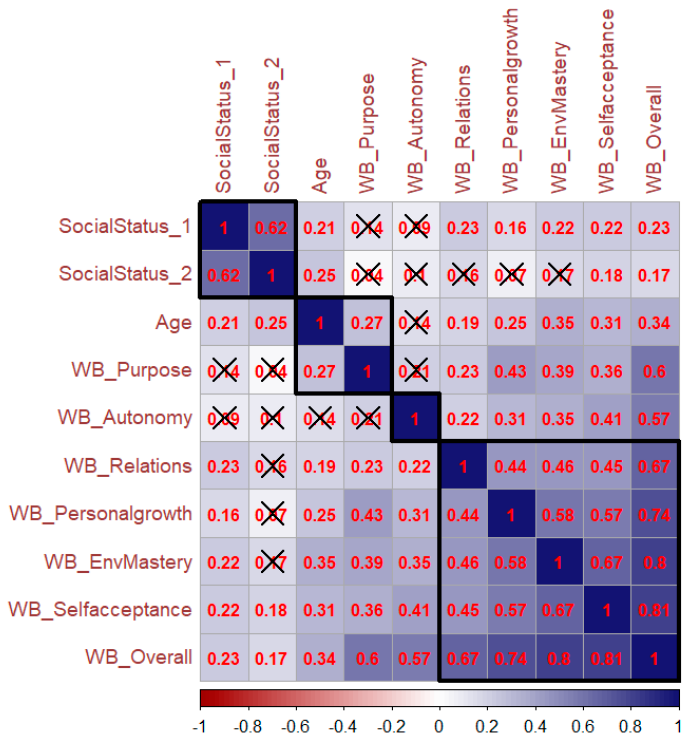
Figure 5. Correlations between WB components and chosen metric variables (women).